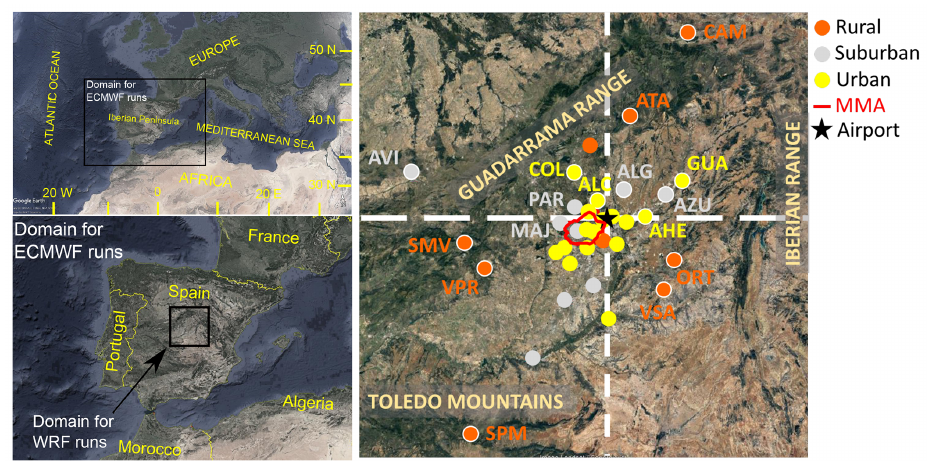
Figure 1. Situation maps of the Iberian Peninsula and the MAB with the indication of the domains used for the simulations with LOTOS- EUROS. In the map located on the right side, the selected set of monitoring stations used for illustrating O 3 variability in different sectors of the region is shown. Stations’ codes: Alcalá de Henares (AHE), Alcobendas (ALC), Algete (ALG), Ávila (AVI), El Atazar (ATA), Azuqueca de Henares (AZU), Campisábalos (CAM), Colmenar Viejo (COL), Guadalajara (GUA), Majadahonda (MAJ), Orusco de Tajuña (ORT), San Martín de Valdeiglesias (SMV), San Pablo de los Montes (SPM), El Pardo (PAR), Villa del Prado (VPR), and Villarejo de Salvanés (VSA). The white dashed lines indicate the E–W and N–S cross sections presented in figures from Sect. 3.2. Basemaps obtained from the US Department of State Office of the Geographer and Landsat/Copernicus; ©Google 2018; ©GeoBasis-DE/BKG 2009; Data SIO, NOAA, US Navy, NGA,